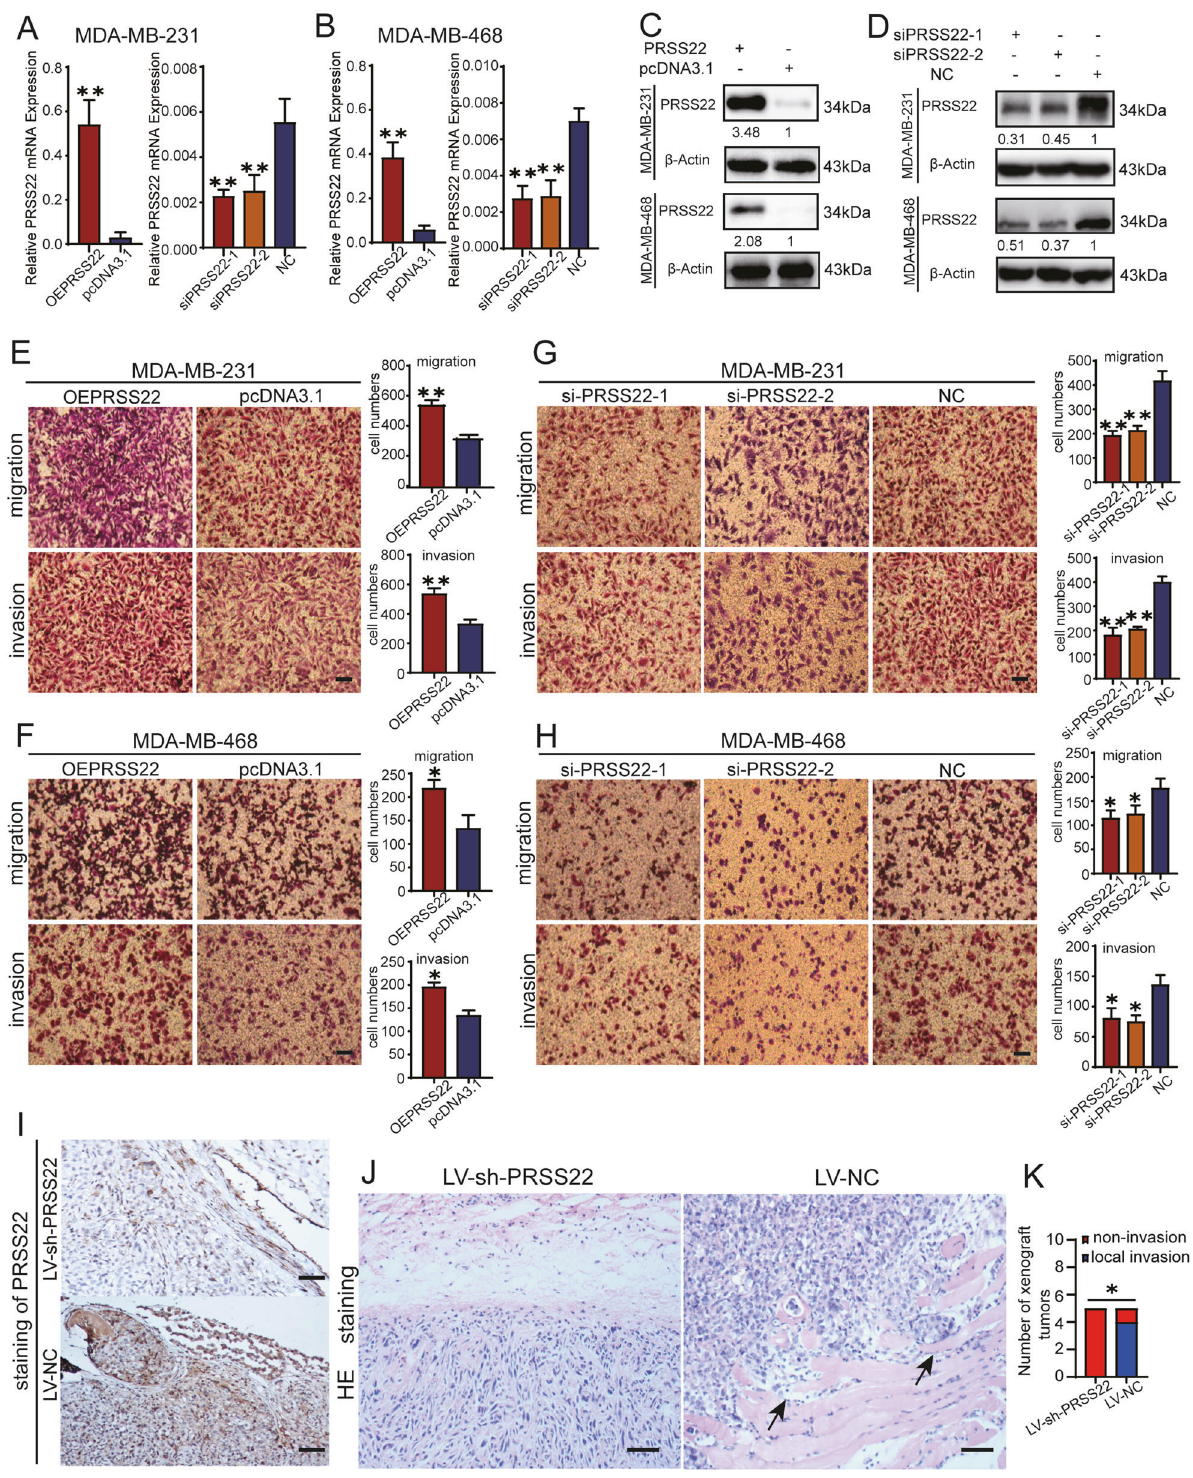
Fig. 3 PRSS22 promotes BC cells migration and invasion. A – D The overexpression ef fi ciency and knockdown ef fi ciency of PRSS22 in BC cells. E – H Transwell assays showed that overexpression of PRSS22 enhanced the migratory and invasive ability of BC cells, while knockdown of PRSS22 inhibited migratory and invasive capacity (Scale bars, 100 μ m). Each experiment was performed in triplicate. I Immunohistochemistry staining of PRSS22 in xenograft tumors (magni fi cation ×200, Scale bars, 50 μ m). J The xenograft tumors of LV-NC group displayed local invasion, with cancer cells invading into the surrounding muscle tissues (the black arrow), the tumors of LV-sh-PRSS22 group were well- encapsulated (HE magni fi cation ×200, Scale bars, 50 μ m). K The quanti fi cation of local invasion of xenograft tumors and associated statistical analyses. Data are shown as mean ± SD of three independent experiments, * P < 0.05, ** P < 0.01, *** P < 0.001, ns not signi fi cant.